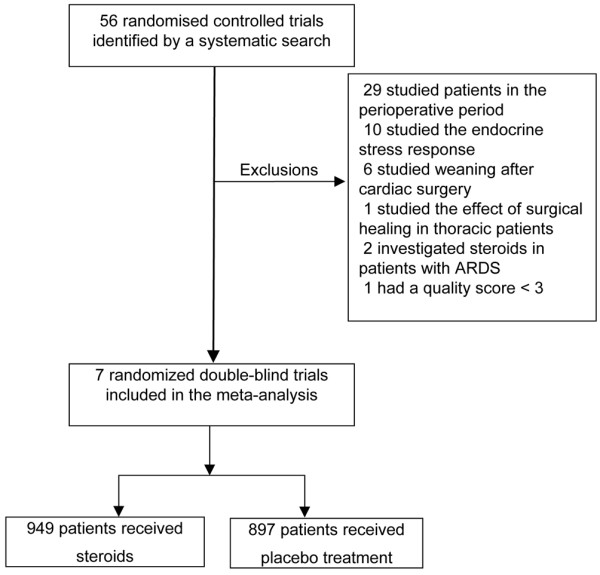
Flowchart of randomised controlled trials selected for the meta-analysis. ARDS = acute respiratory distress syndrome.